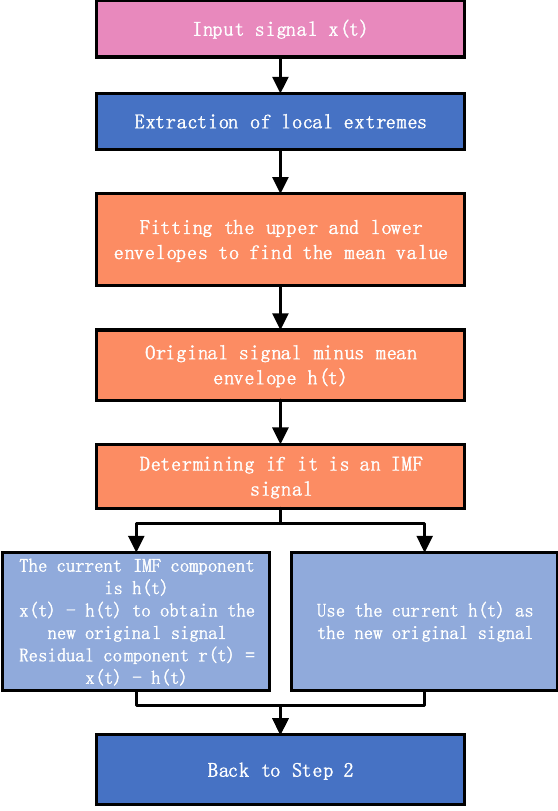
Figure 11. The rendering of EMD.